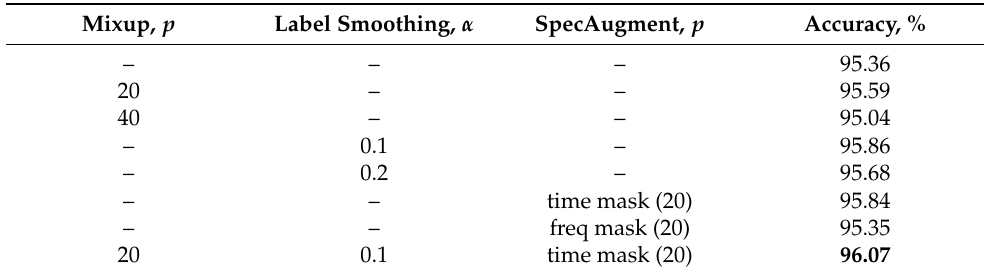
Table 8. Accuracy results of applying audio data augmentation techniques. Mixup,